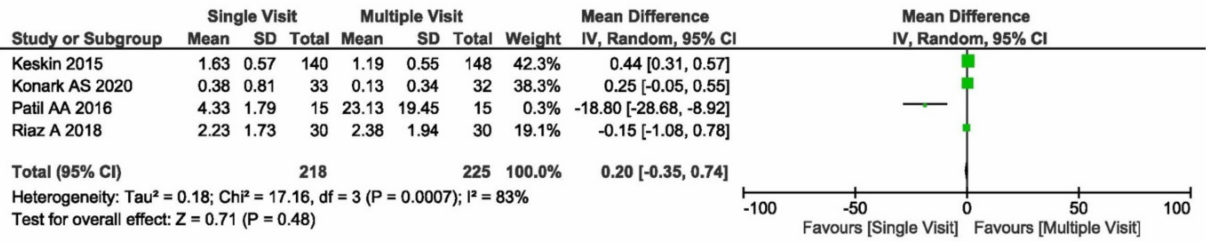
Figure 4. Meta-analysis summarizing the comparison of the intensity of postendodontic pain and flareup between single and multiple visit RCT as measured by the modified VAS with a pain scale of 1 to